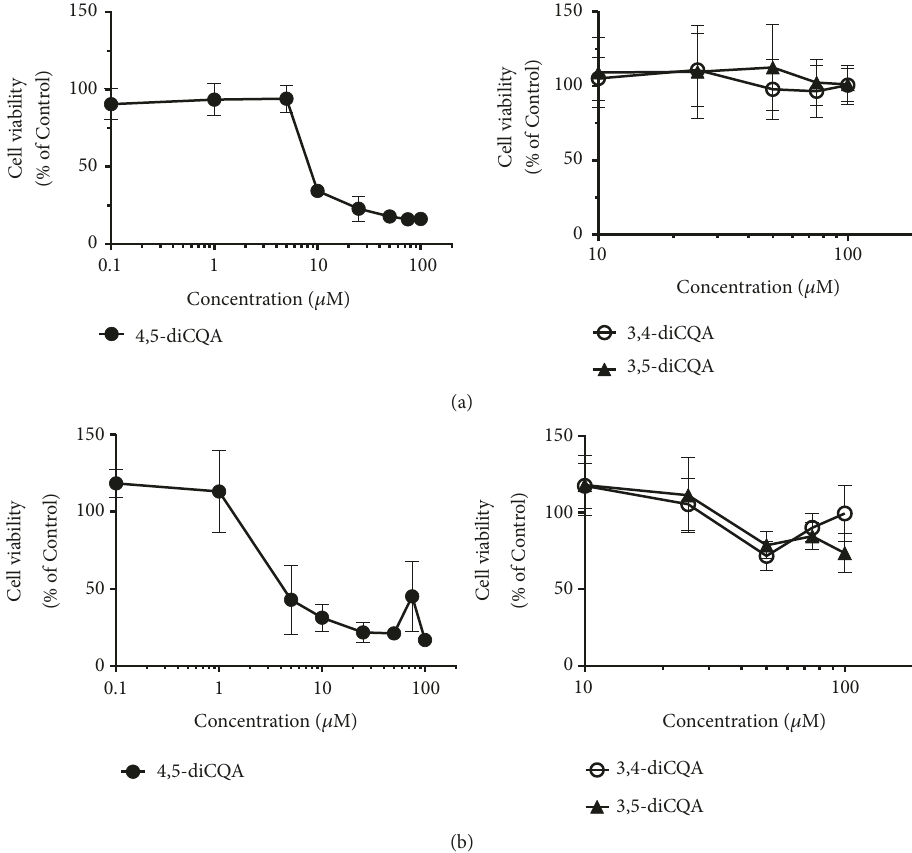
Figure 1: Cytotoxicity profile of diCQA analogs on DU-145 prostate cancer cells . (a) Cytotoxicity of 3,4-diCQA, 3,5-diCQA, and 4,5-diCQA on DU-145 cells in normoxic conditions was determined using CCK-8 assay. Mean values ± standard deviations from 8 trials are represented. (b) The cytotoxic effects of 3,4-diCQA, 3,5-diCQA, and 4,5-diCQA on DU-145 cells in hypoxic conditions were determined via CCK-8 assay. The means of the 8 trials were graphed along with their standard